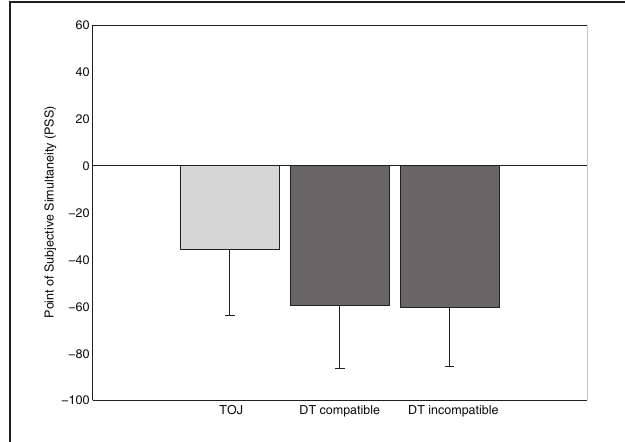
FIGURE 4 | Points of subjective simultaneity (PSS) for the temporal-order judgment task (TOJ) and the two dual-task (DT) conditions (compatible and incompatible stimulus-response mapping) in Experiment